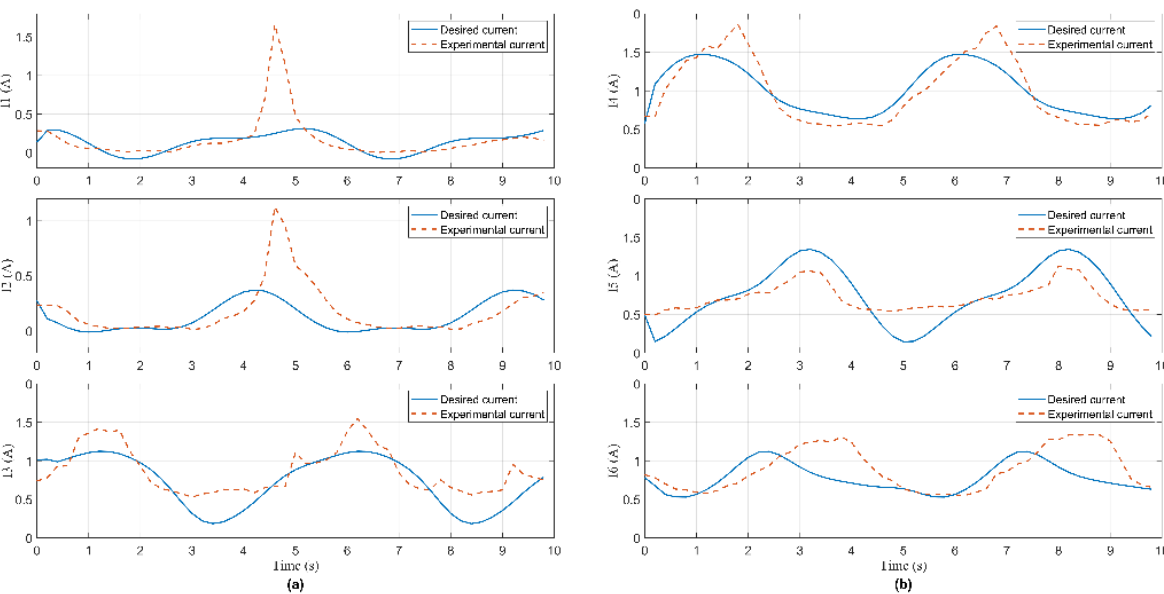
Figure 20. Current signal measured from current sensors in Case 3: ( a ) The 1st, 2nd, and 3rd sensor; ( b ) the 4th, 5th, and 6th